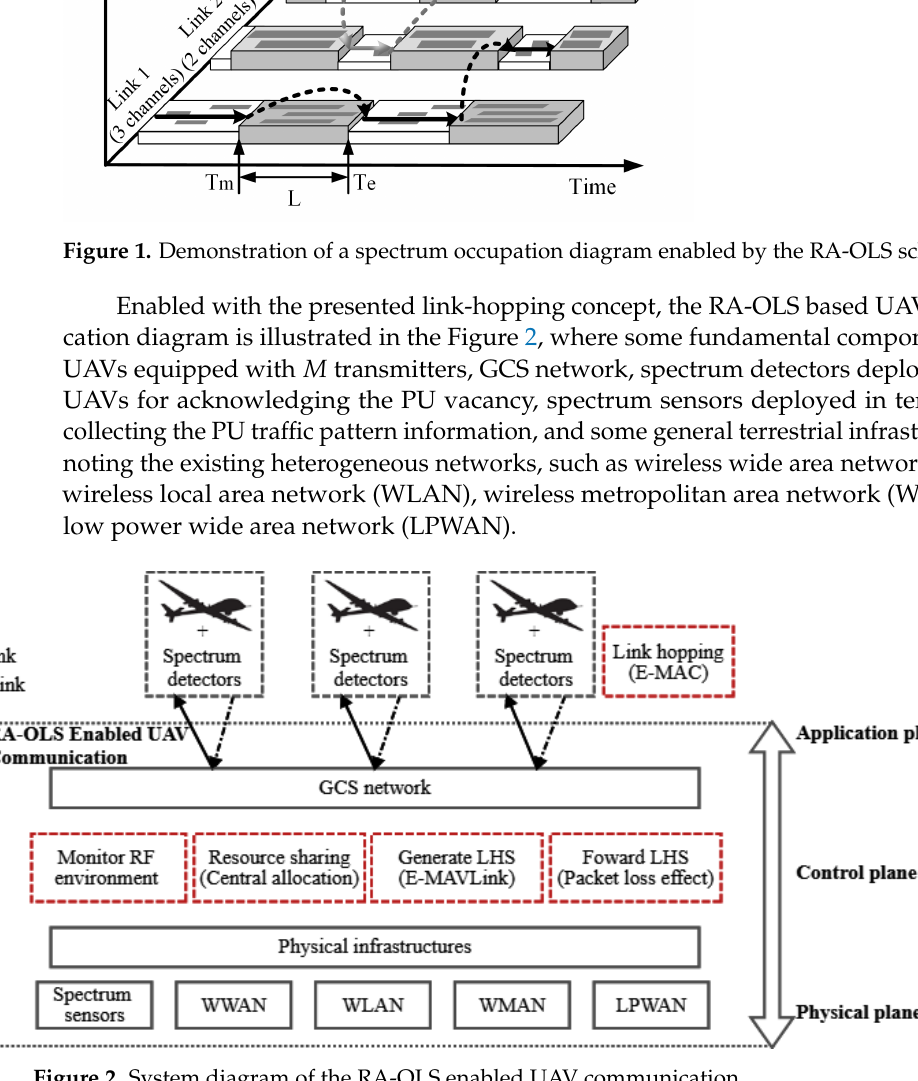
Figure 2. System diagram of the RA-OLS enabled UAV